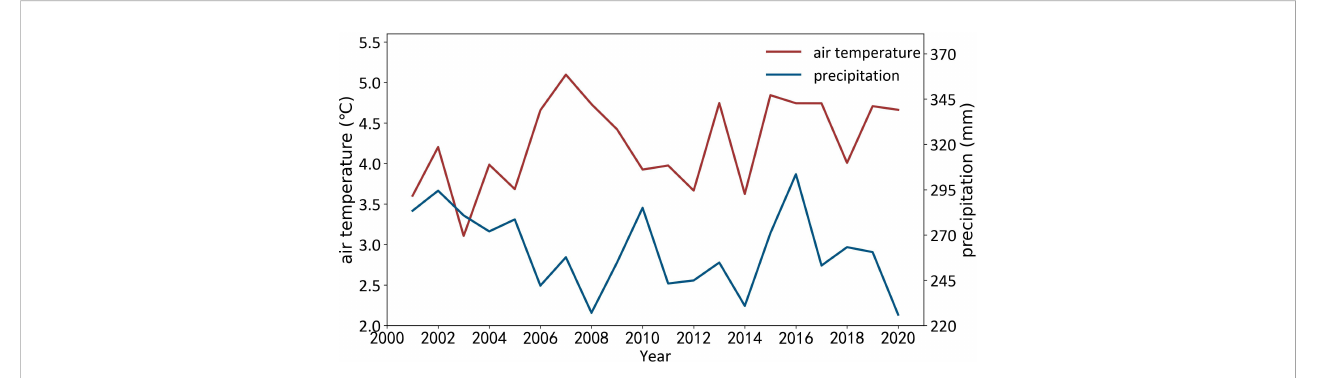
FIGURE 7 Temporal variations of annual precipitation (A) and air temperature (B) over Xinjiang from 2001 to 2020.